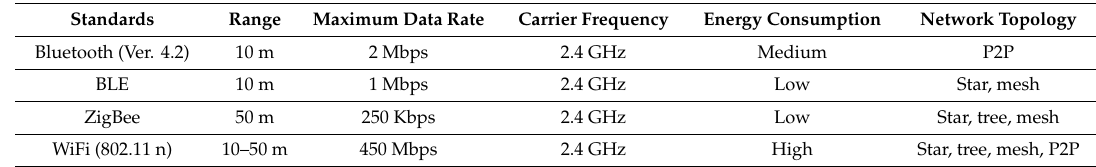
Table 3. Alternative wireless communication standards for HAR.